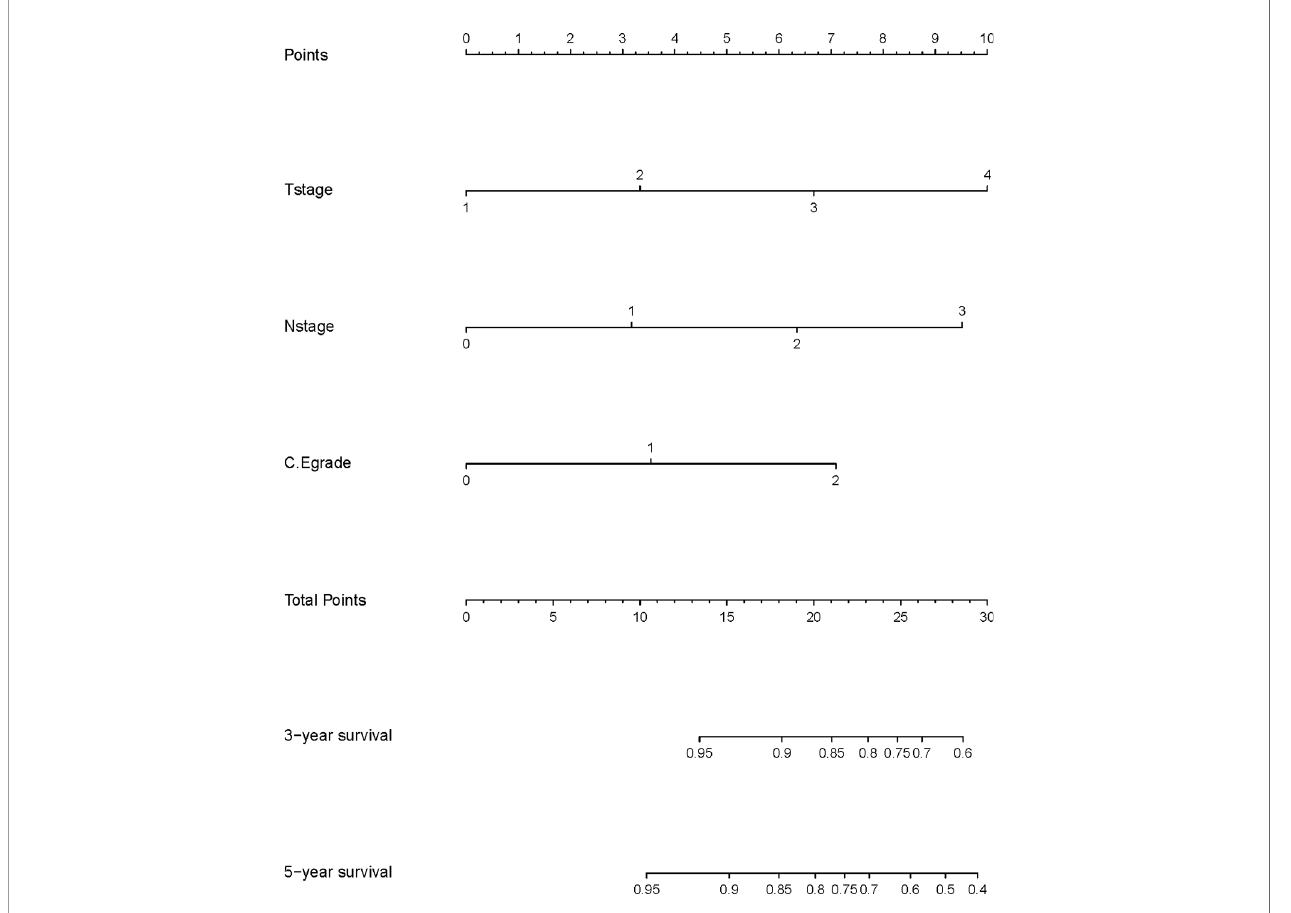
FIGURE 3 | A nomogram predicting the 3- and 5-year overall survival of NPC patients.